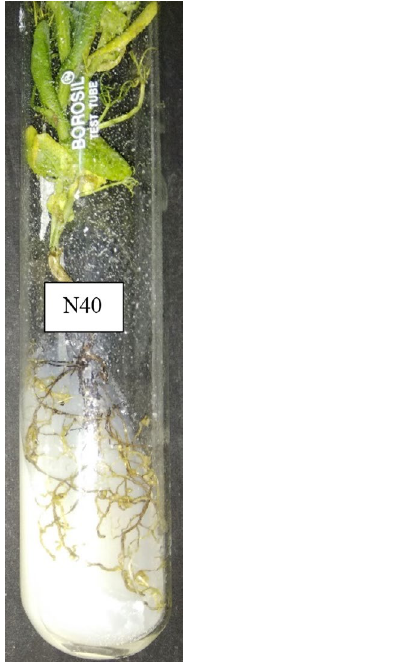
Fig. 2. Growth of Rhizobium strains at